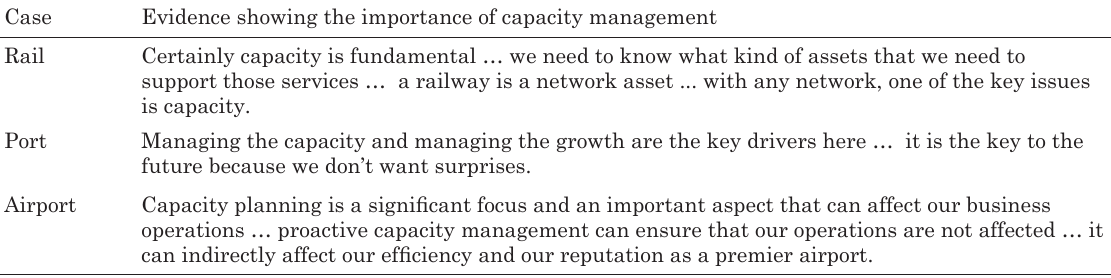
table 2. Importance of the capacity management process